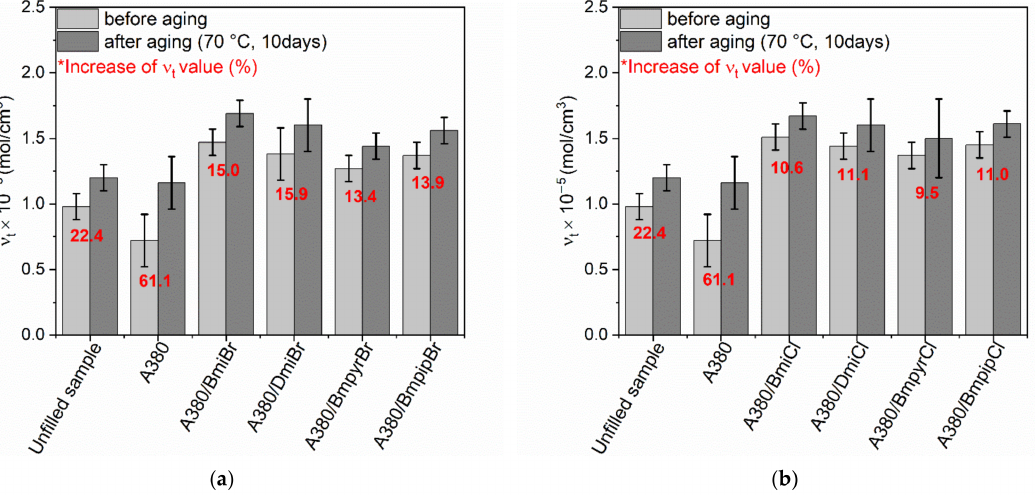
Figure 4. Influence of thermo-oxidative aging on the crosslink density of the silica-filled NR vulcan- izates containing ILs with: ( a ) bromide anion; ( b ) chloride anion.